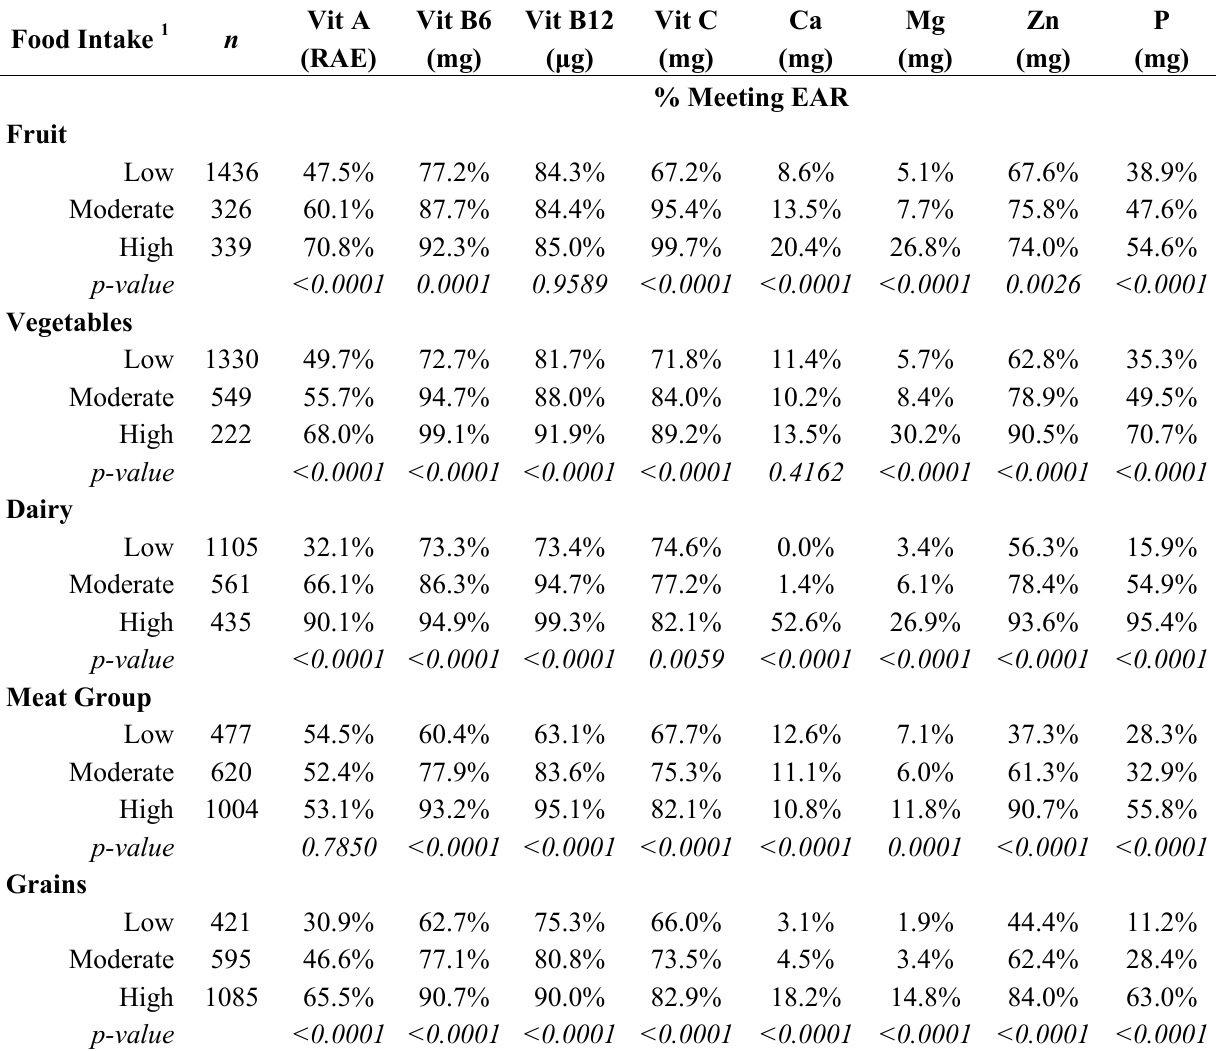
Table 4. Percent of 14–18-year-old girls meeting micronutrient EARs by level of food group